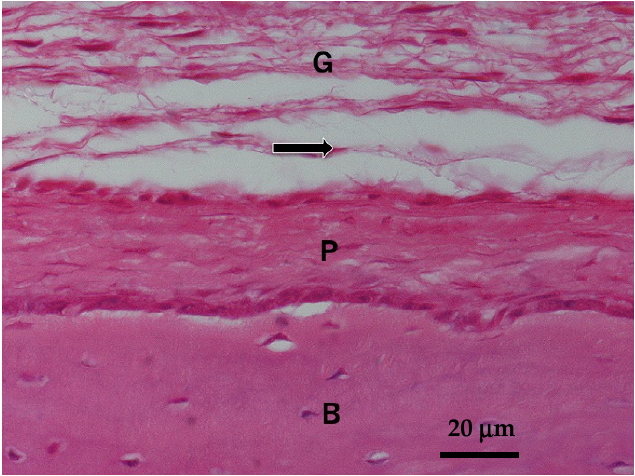
Figure 2. Normal skull structure of four-week-old Wistar rat. Arrow indicating implanted tissue region. B: skull bone; P: periosteum; G: